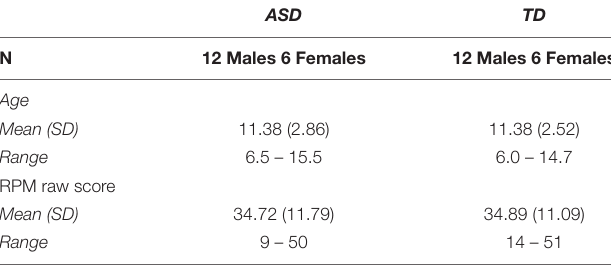
TABLE 1 | Gender, age, and raw RPM scores for the ASD and TD